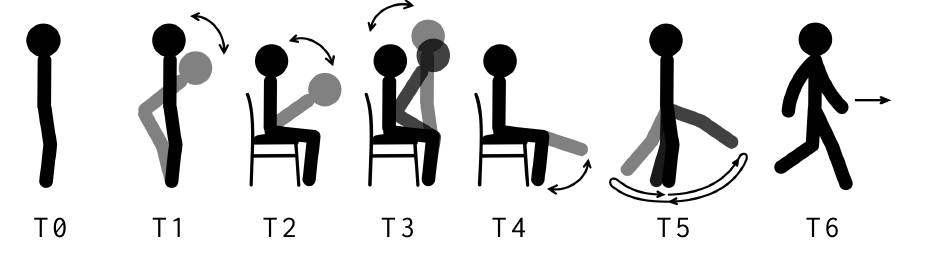
Figure 3. Tests in the experiment of anatomical